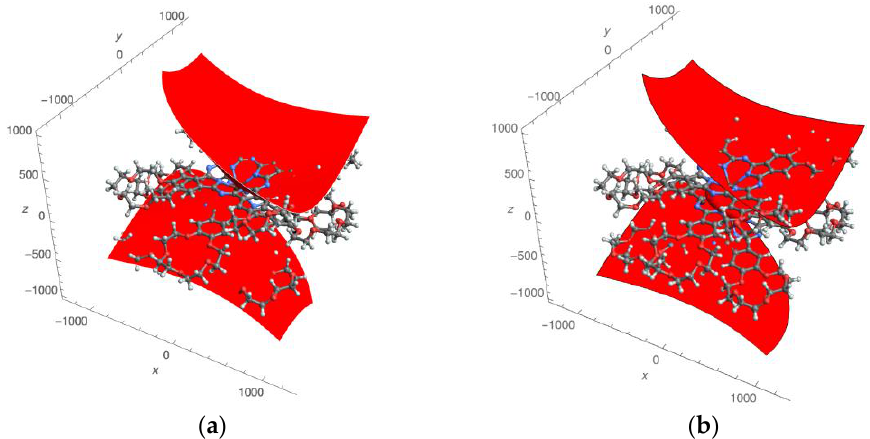
Figure 5. Two surfaces with zero values of pseudo-contact contributions to lanthanide-induced shifts created by only one paramagnetic cation ( a ) in the Dy complex; three surfaces with zero values of pseudo-contact contributions to lanthanide-induced shifts created by two paramagnetic centers ( b ).